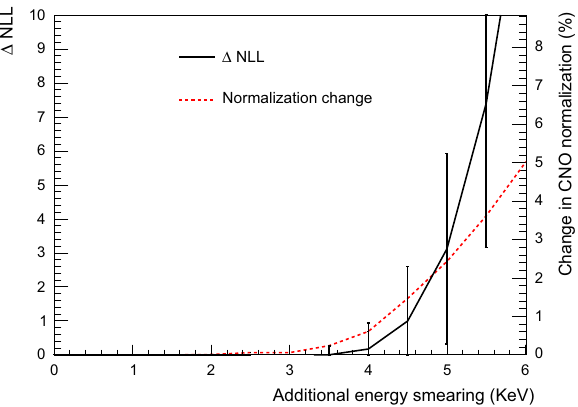
Fig. 10 Result of systematic change in energy resolution modeled by an additional fixed width smearing of the energy PDF. The solid line shows the Δ NLL from fitting with a shifted PDF relative to the true PDF, with the error bars showing the RMS of the Δ NLL for many fake data sets, while the dashed line shows the change in the mean extracted normalization of the CNO flux when fitting with a shifted PDF. Results are for 5 years of data with the baseline detector configuration and background assumptions Table 6 Fit uncertainty for 5 years of data with the baseline detector configuration as a function of the energy threshold Energy threshold (MeV) CNO sensitivity (%)